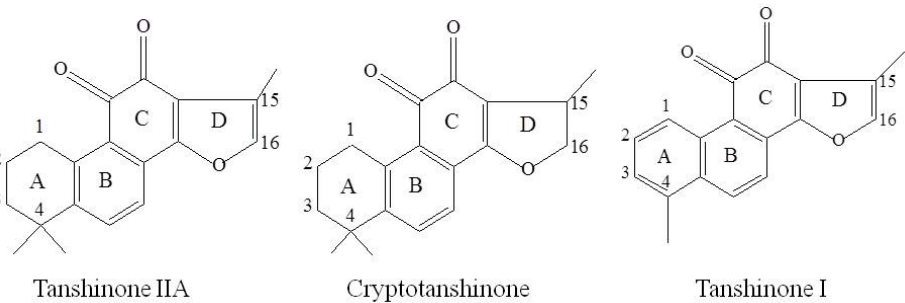
Figure 1. Structures of TIIA, Cry and TI in Radix Salvia miltiorrhiza used in this